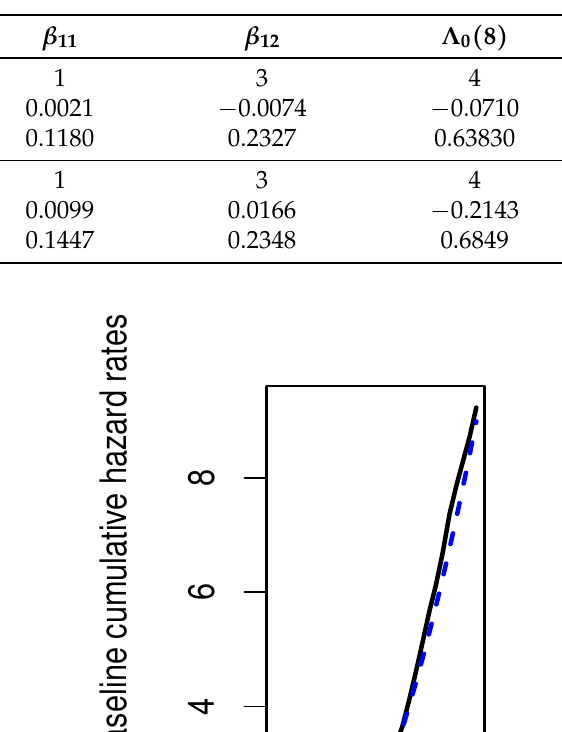
Table 6. The empirical bias and sample standard error (s.d.) of the estimator ˆ β 11 , ˆ β 12 and ˆ Λ 0 ( 8 ) based on 100 replications in Example 3.